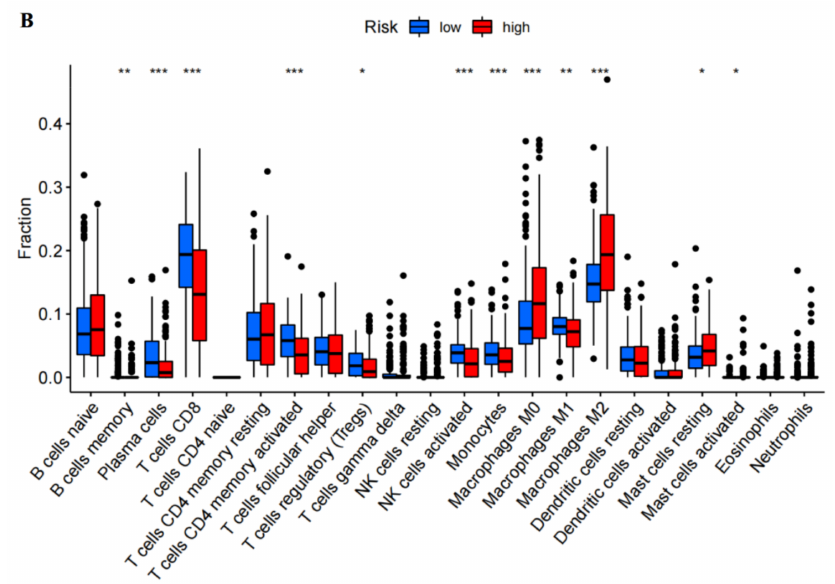
Figure 8. The immune infiltration of malignant melanoma patients with high and low-risk scores and the correlation between immune cell infiltration and risk score. ( A ) Bar plot demonstrating the relative proportion of 22 types of infiltrating immune cells in malignant melanoma patients with a high and low-risk score. ( B ) Box plot demonstrating the ratio differences of 22 types of immune cells in malignant melanoma patients with a high and low-risk score (* p < 0.05, ** p < 0.01, *** p < 0.001).